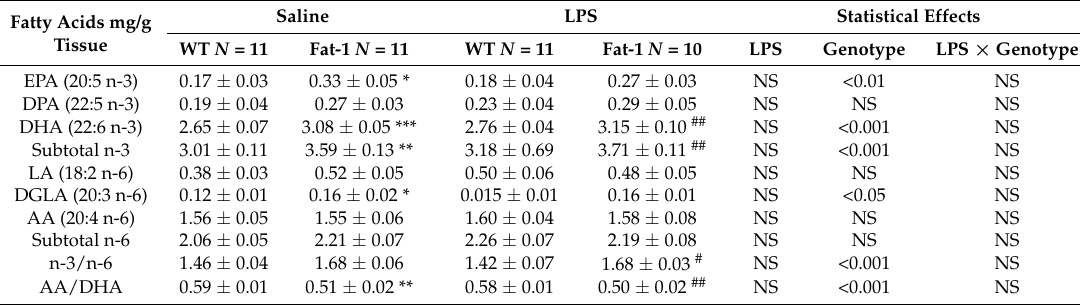
Table 2. Fatty acid profile in mouse brain tissue.